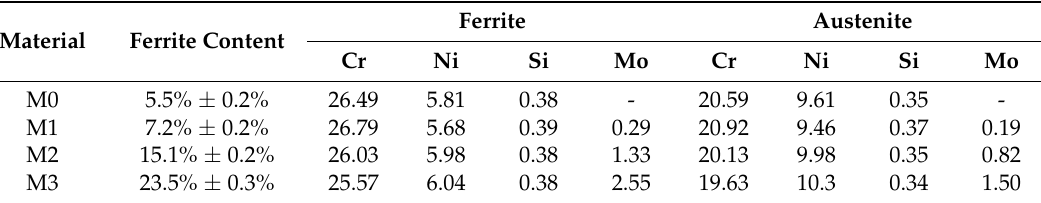
Figure 1. SEM images of the studied model alloys showing their duplex (austenite + ferrite) microstructures. (M0, M1, M2, and M3 corresponds the alloy with Mo content of 0.0, 0.20, 0.90, and 1.75 wt%, respectively.)